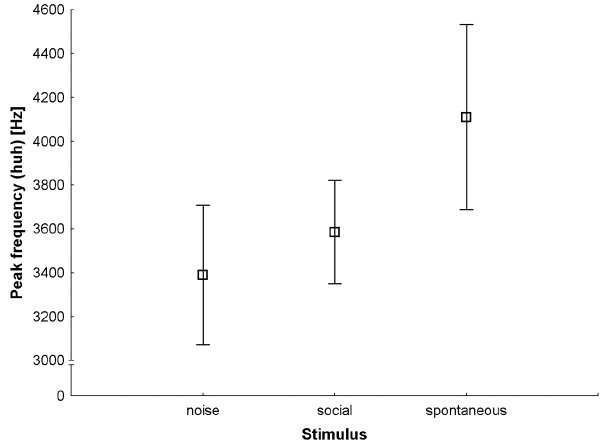
Figure 4. Mean ± 95% confidence interval for peak frequency of huh syllables across contexts.